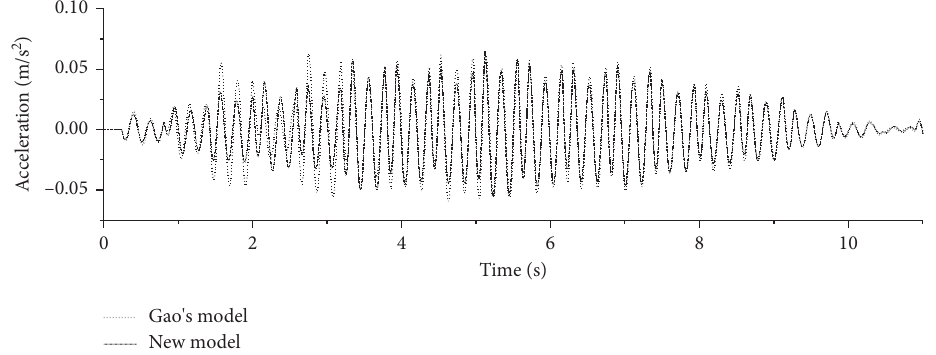
Figure 5: Acceleration of the beam at mid-span (initial vector not